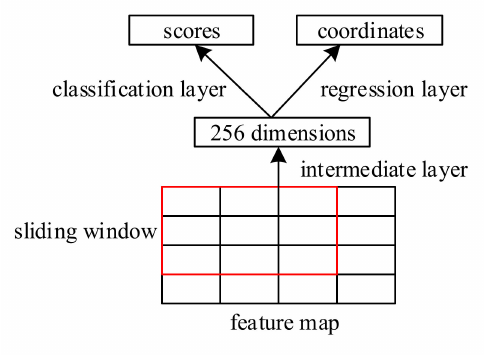
Figure 2. Region proposal